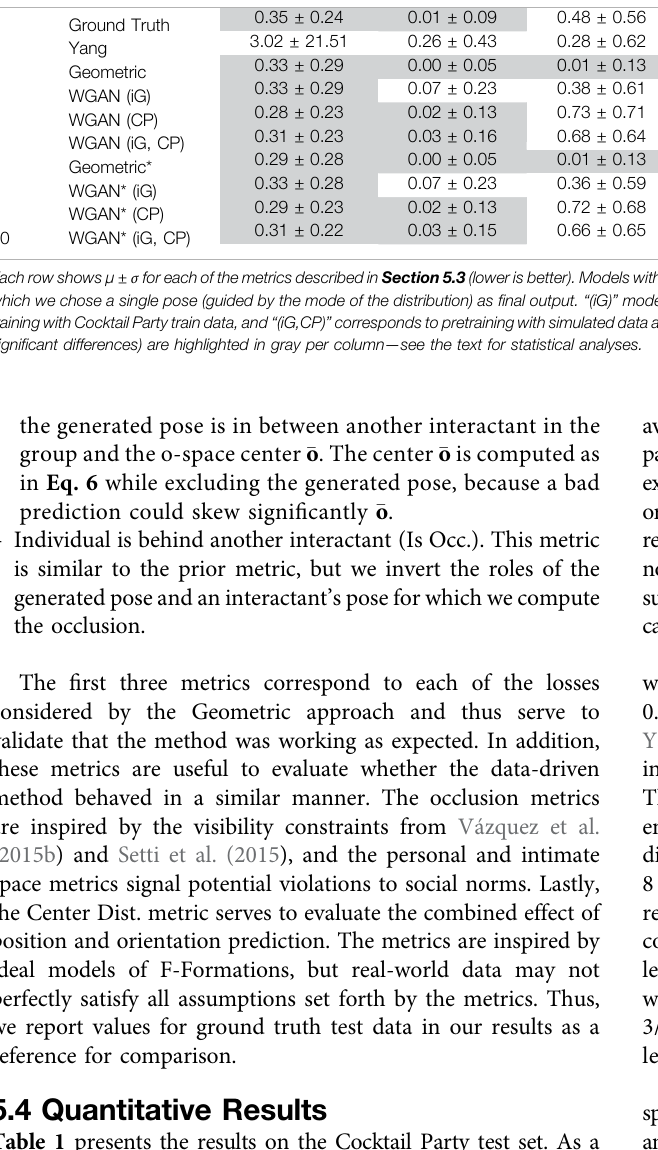
TABLE 1 | Results on the Cocktail Party test set. Method Circ. Fit Not Free Per.